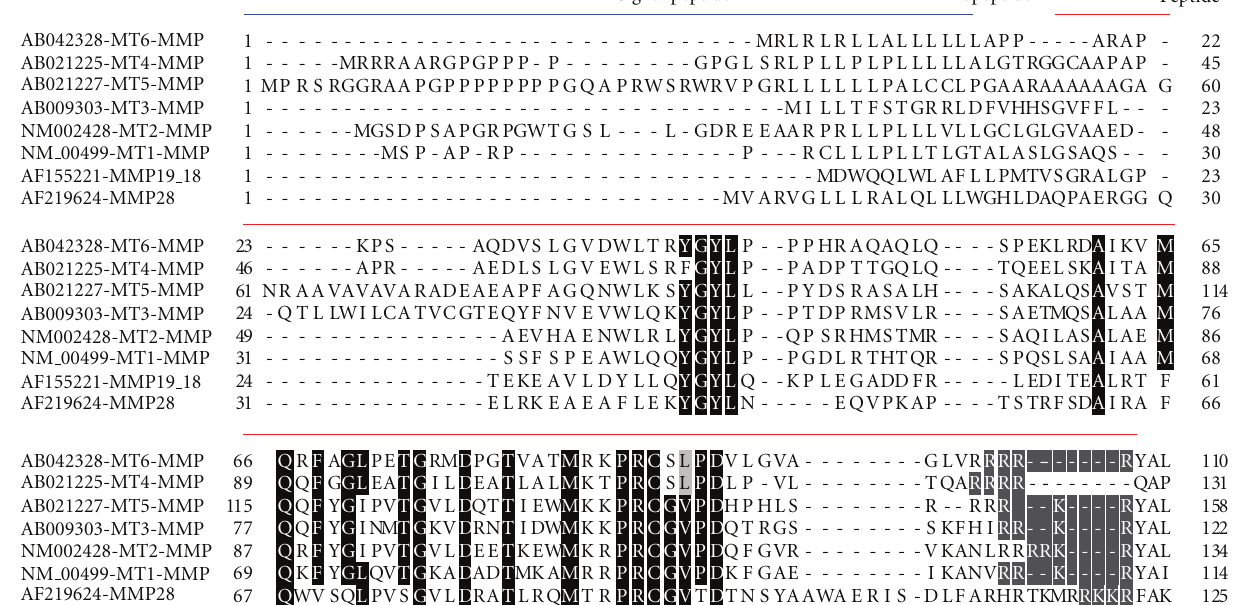
Figure 1: Alignment of the propeptide domain of YGYL containing MMPs. The intramolecular chaperone sequence of YGYL, cysteine switch sequence of PRCGVPD, and all conserved amino acids within the propeptide domains of MMPs are highlighted in black, and furin consensus sequence of RXXR motif is highlight in gray. Blue line represents a signal peptide and red line represents propeptide